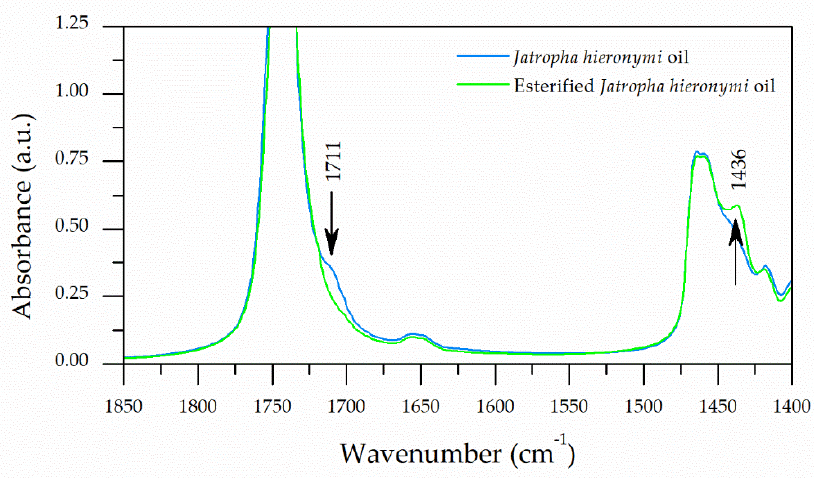
Figure 5. Comparison of Jatropha hieronymi oil FT-IR spectra before and after esterification.